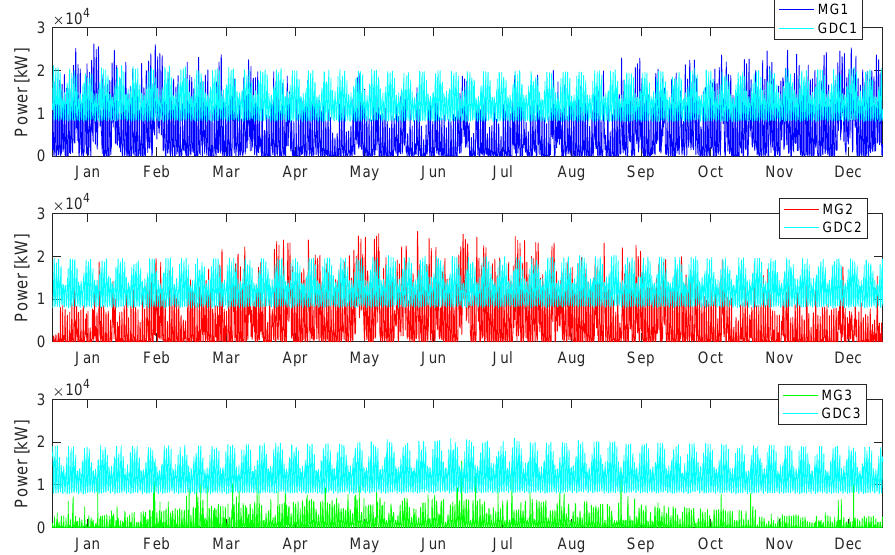
Figure 5. Hourly renewable power generation (MGx) and GDC load demand (GDCx) for the three microgrids in the Base Scenario. If the two lines reach the same height, the same amount of power was generated and used for computation